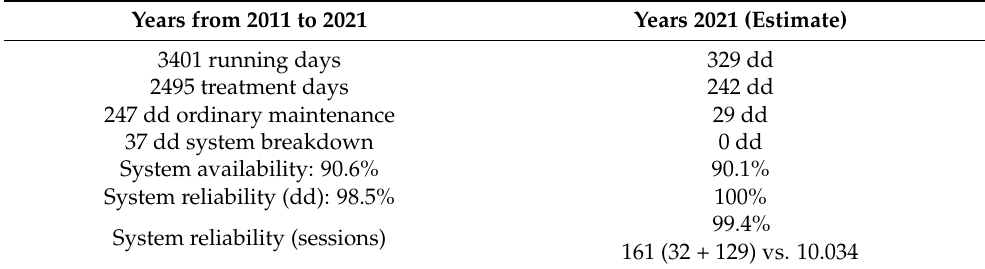
Table 2. CNAO performances from first patient treatment (fall 2011) to end of 2021. The data of year 2021 are available until October; the last months are estimated assuming the same trend. Years from 2011 to 2021 Years 2021 (Estimate) 3401 running days 329